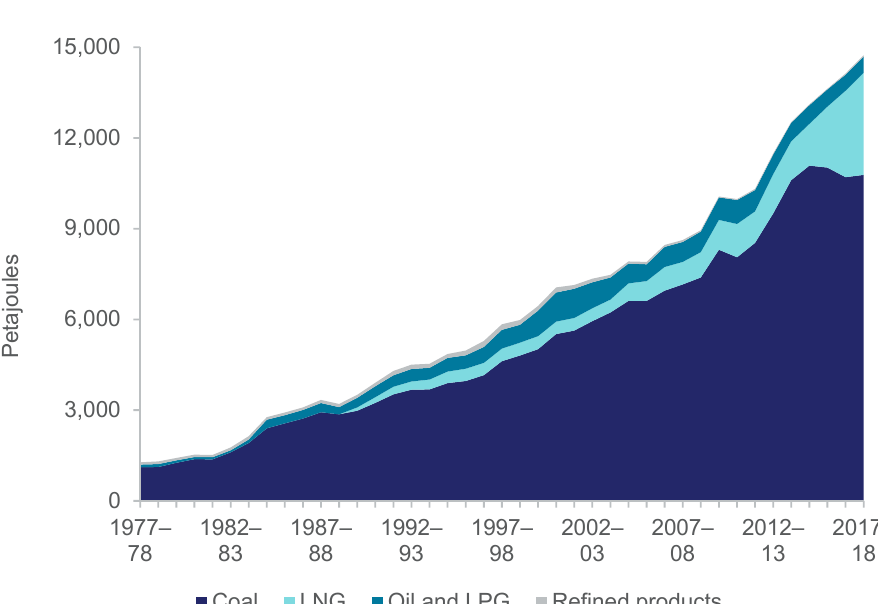
Figure 2. Australia’s energy exports by fuel type (Australian Government Statistics, 2019).